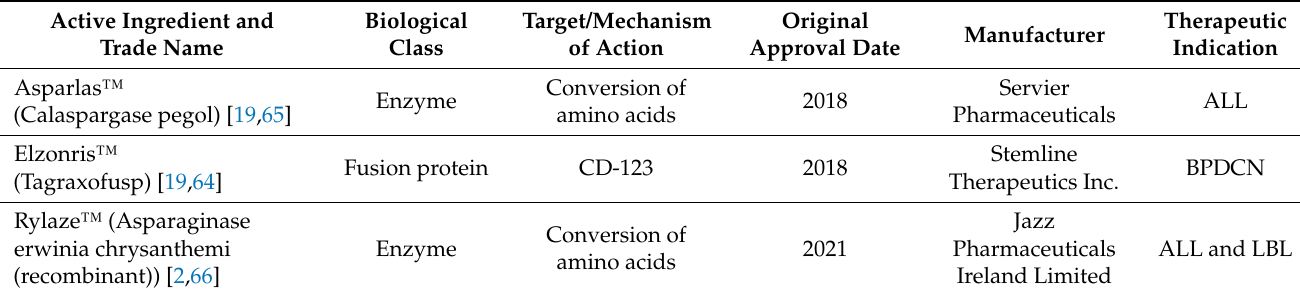
Table 5. Enzymes and proteins for cancer approved by the Food and Drug Administration from 2015 to 2021.